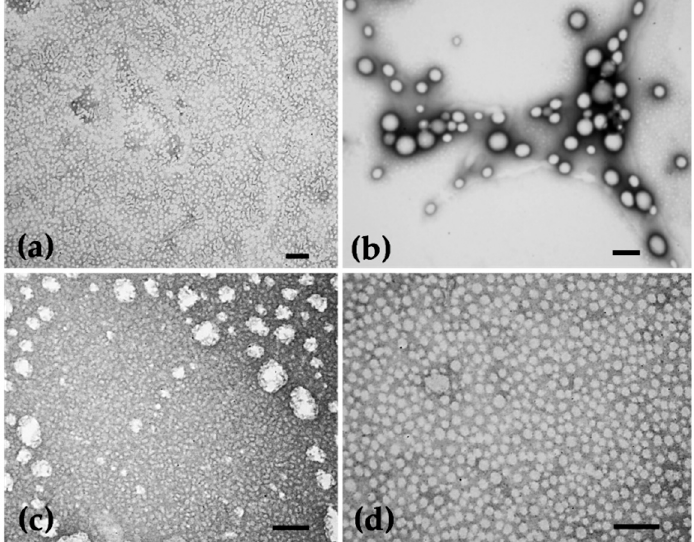
Figure 6. TEM micrographs showing the morphology of NPs. ( a ) Empty PLGA NPs, ( b ) Extract-loaded PLGA NPs, ( c ) Empty PCL NPs and ( d ) Extract-loaded PCL NPs. Scale bars = 0.2 μ m ( a , b , c ), 0.1 μ m ( d ).